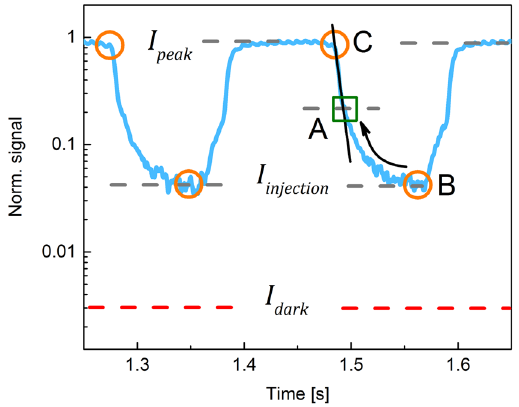
Figure 7. The response of PbO detector to subsequent 100 ms X-ray pulses at F = 2 V/ μ m plotted in the semi- log scale (taken from the middle section of the graph shown in Fig. 2). Points C and B represent the total current and the injection current levels, respectively, while point A defines the inflection point in the signal decay, i.e. the beginning of